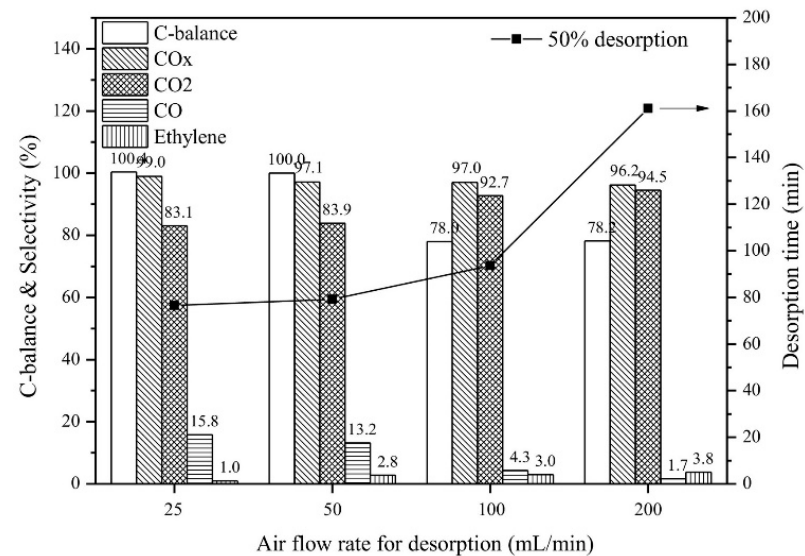
Figure 23. Effect of air flow rate on the performance of 2 wt% Fe/ZSM-5 packed DBD reactor for toluene oxidation. Reprinted from Reference [117], with permission from Elsevier.